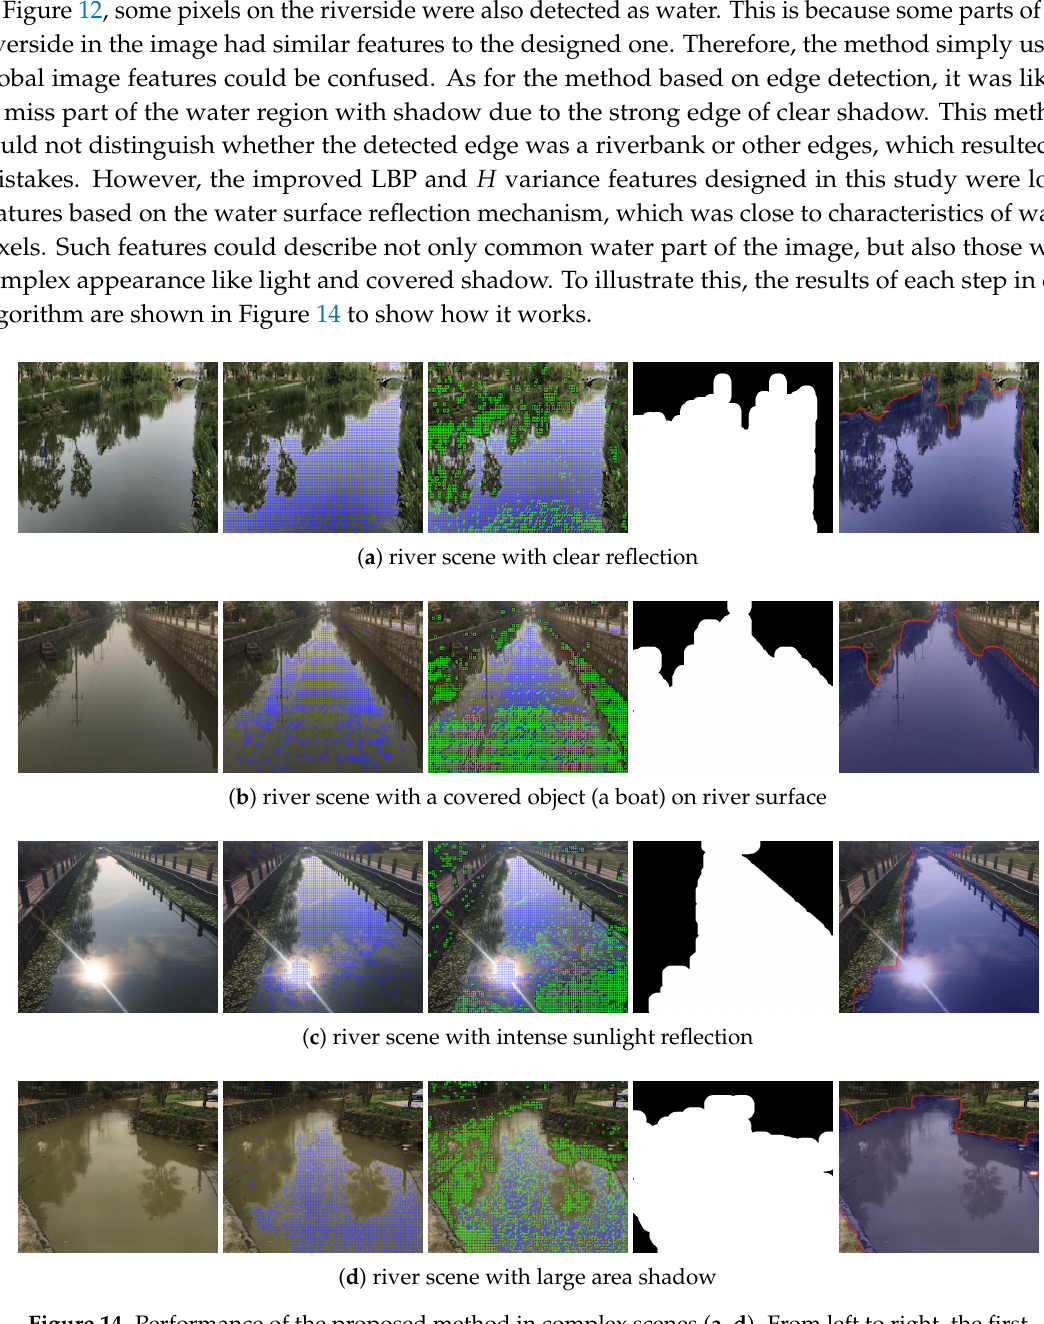
Figure 14. Performance of the proposed method in complex scenes ( a – d ). From left to right, the first column includes the images after pre-processing. In the second column,The blue squares in images represent the detection result of water region with the improved LBP feature. In the third column the green squares represent the detection result by H -variance feature developed from the second column images. The fourth column images are the binary mask of detection results after the designed morphological operation. The fifth column images are final segmentation results of river region indicated by a covered translucent blue